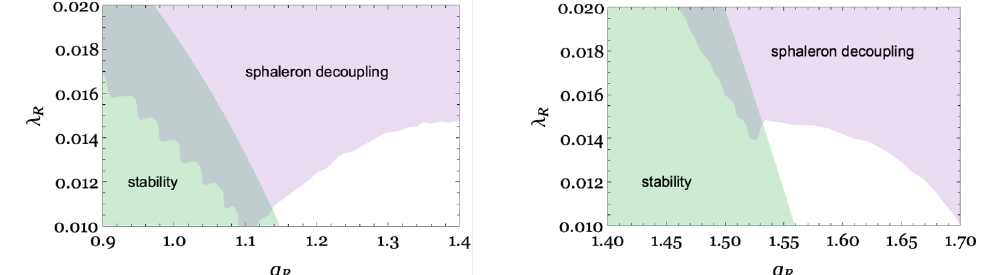
Figure 2 . The region of g R and λ R excluded by the sphaleron decoupling condition (purple) and the stability of the zero-temperature effective potential below 10 v R = 150 TeV (green). We take y E = 0 . 8 , y E = 0 . 7 , y N = 0 . 7 and y N = 0 . 8 in the left panel and y N 3 2 2 3 the right